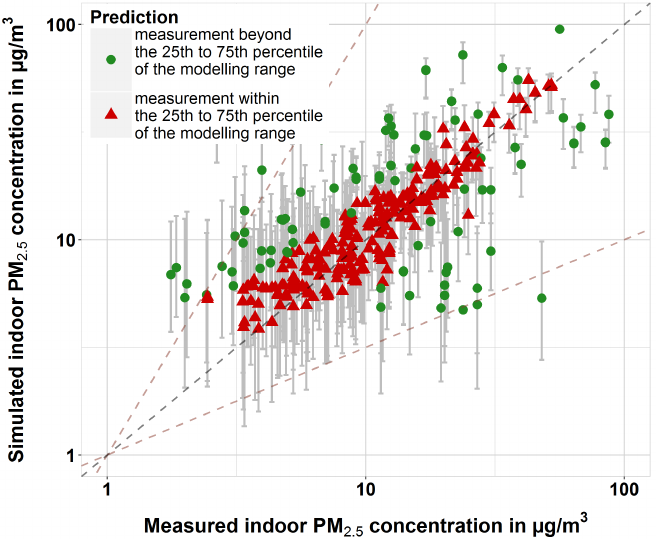
Figure 12. Validation for PM 2.5 . The red dot represents the measurement that is within the corresponding 25th to 75th percentile of the modelling range, while the green dot is beyond that range. For PM 2.5 70% of the dots (258 out of 370) are within the range.